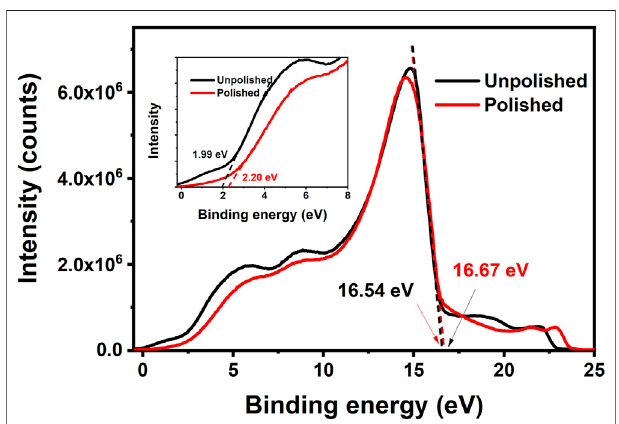
FIGURE 7 | UPS spectra of samples before and after polishing.